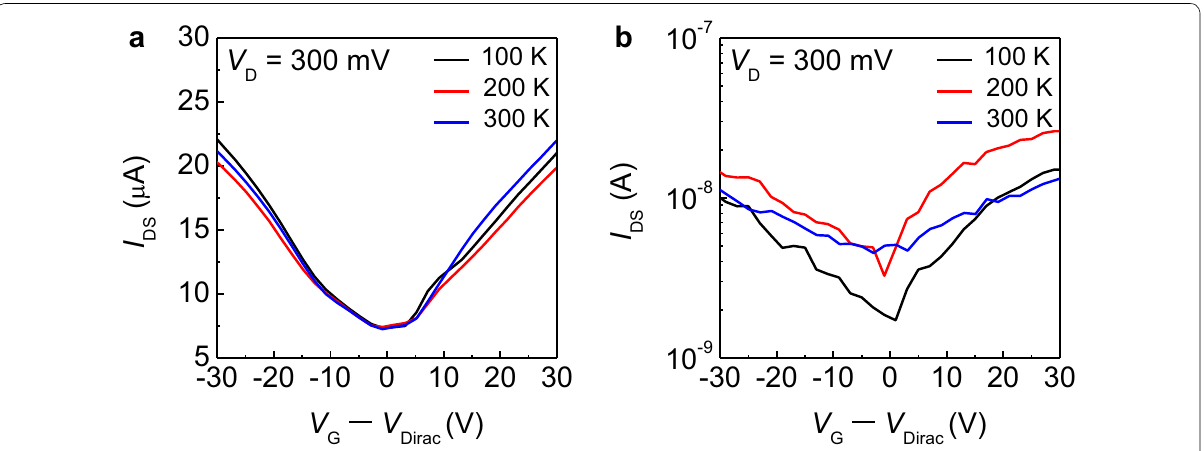
Fig. 6 I DS – V G characteristics of FETs based on a unpatterned graphene and b 100‑nm wide GNR, measured at temperatures of 100–300